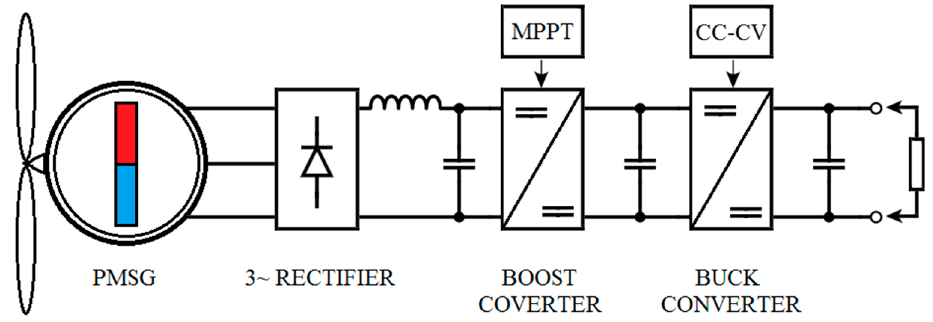
Figure 2. Hydrokinetic turbine with maximum power point tracking (MPPT) control algorithm.